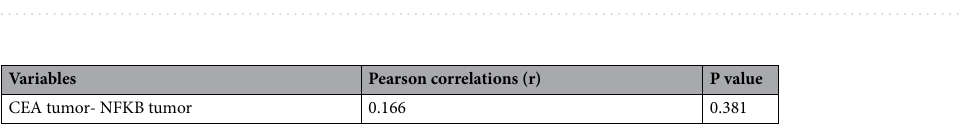
Figure 6. Comparison between CEA expression in tumoral tissues versus IBD and resection margins ( p < 0. 05).